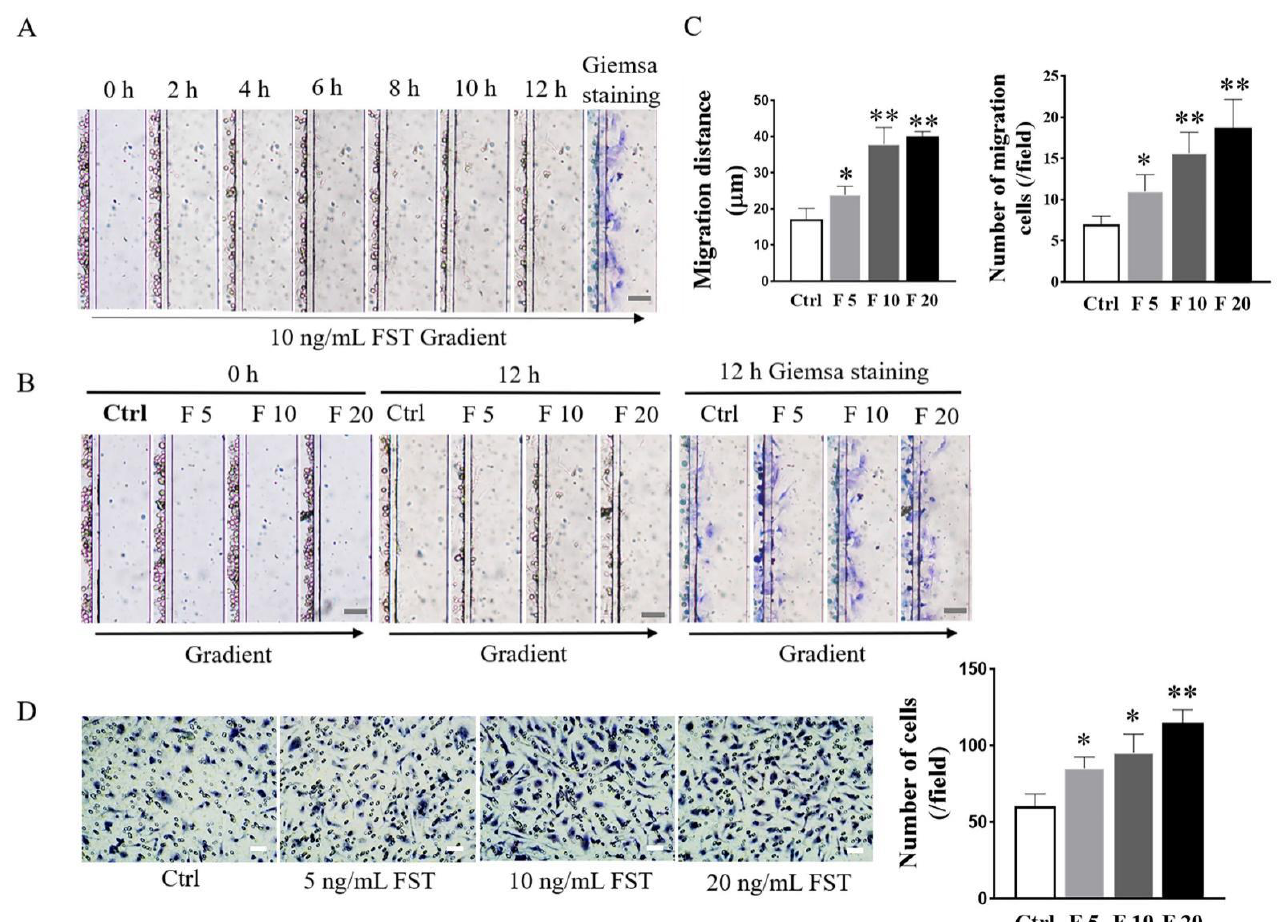
Figure 4. Effects of FST on migration and invasion of mice trophoblasts. ( A ) Images of trophoblast migration towards 10 ng/mL FST gradient were taken every 2 h in microfluidic device. ( B ) Images of trophoblast migration towards 0, 5, 10, and 20 ng/mL FST gradients were taken in the microfluidic device at 0 h and 12 h, respectively. Scale bar = 100 μm. ( C ) The graph showed the average migrated distance ( left ) and the number of migrated cells ( right ) in the same size fields of microfluidic device ( n = 3). Ctrl: 2% FBS culture medium control. F5: 5 ng/mL of FST. F10: 10 ng/mL of FST. F20: 20 ng/mL of FST. * p < 0.05, ** p < 0.01, compared with control. ( D ) Invasion of trophoblasts treated with FST was determined by the Matrigel-coated transwell chamber invasion assay. Representative images of cell invasion were shown and the graph represented the average number of stained cells counted in five randomly chosen fields from each chamber ( n = 3). Scale bar = 50 μm. * p < 0.05. ** p < 0.01, compared with control.